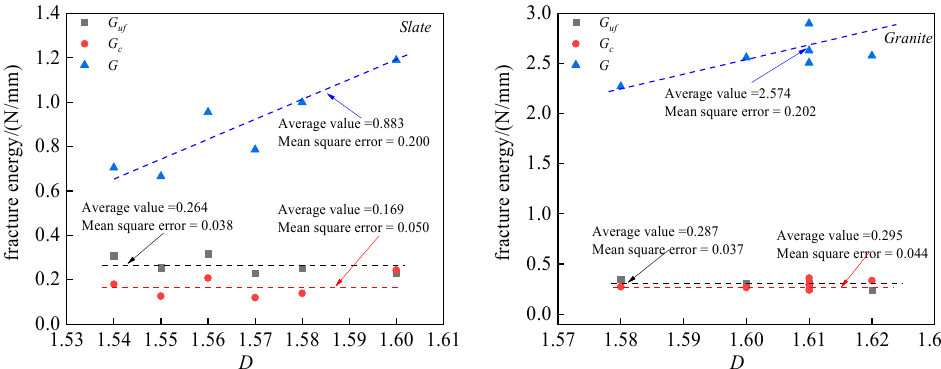
Figure 5. Three fracture energies and complexity D of slate and granite.